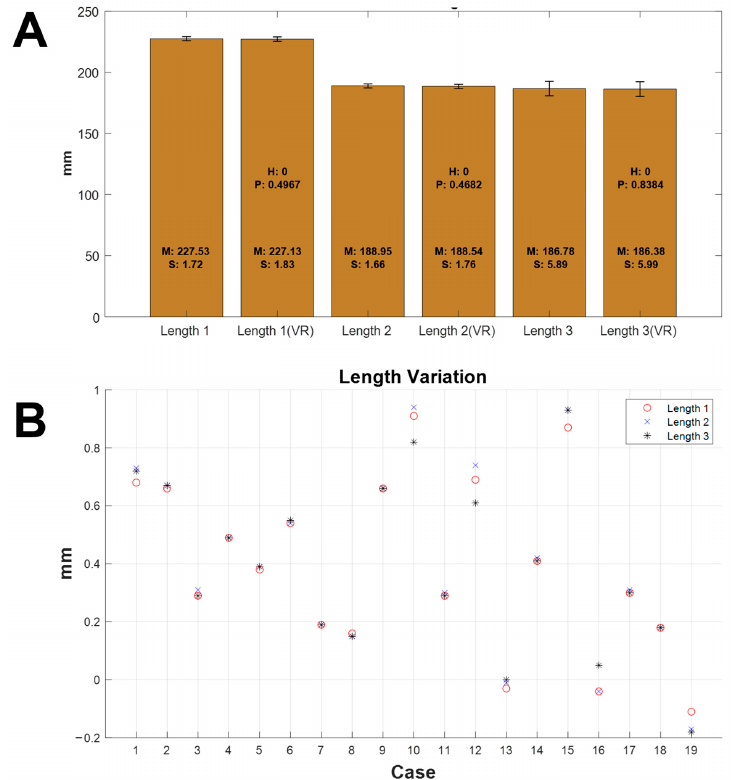
Figure 5. Results of the measured length and length variations between the original object and the virtually reduced object. ( A ) The measured lengths of specific distances (Length 1( ′ ), Length 2( ′ ), and Length3( ′ )) from the original object and the virtually reduced object. ( B ) The length variation in 19 ORTHObones before and after virtual reduction. VR: virtual reduction, M: mean, SD: standard deviation, H: null hypothesis, P: p -value.